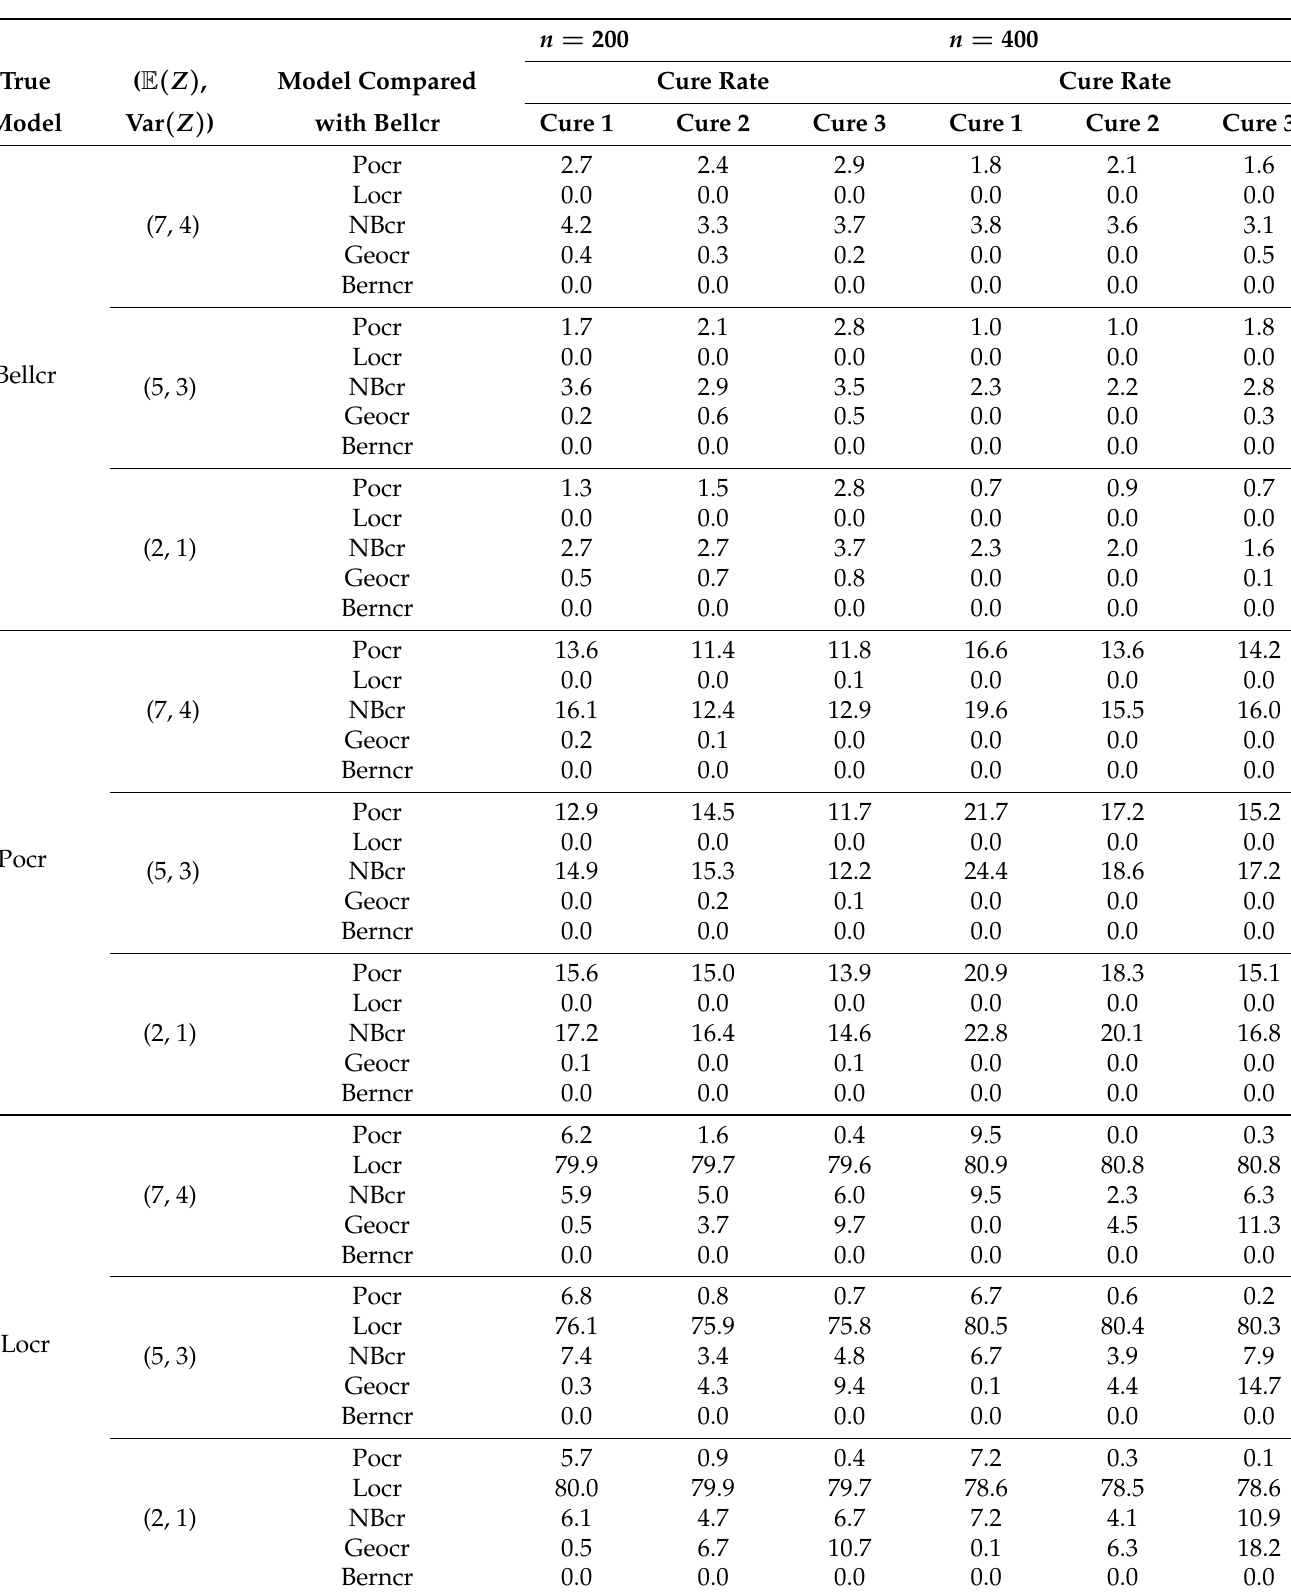
Table 4. Rejection rate (in %) of the Bellcr model when compared with different models using the Vuong’s test statistic—Part 1. n = 200 n =